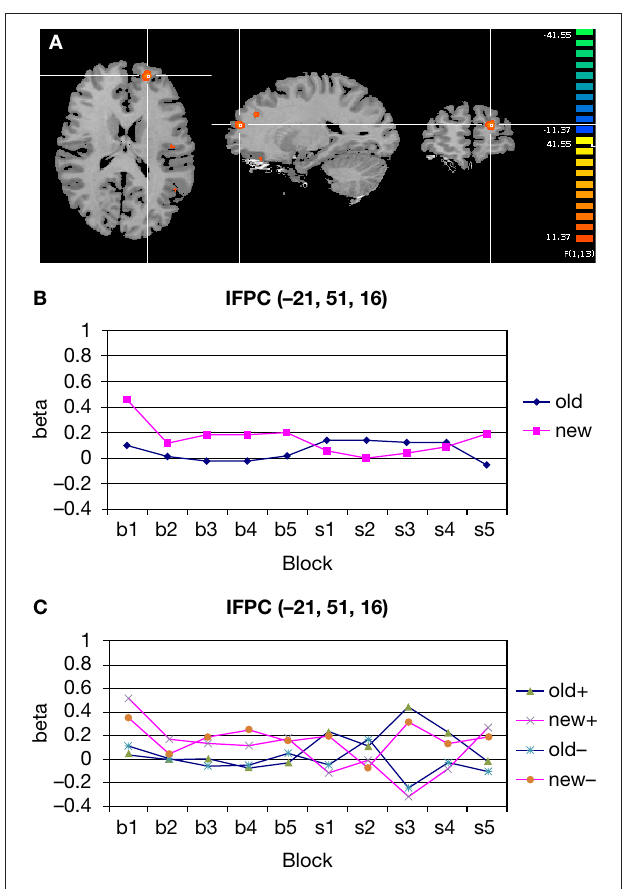
FIGURE 5 | Signifi cant confi guration by change interaction in left frontopolar cortex. (A) Location of left frontopolar activation. The frontopolar activation is marked by the cross hair. Somewhat more dorsally and posteriorly, the superior frontal gyrus activation is visible. Left hemisphere is presented on the right. (B) Group signal strength as a function of condition and block. The graph shows beta values, signifying the amplitude of the modeled BOLD-response. Old: repeated trials, new: novel trials. (C) Signal strength as a function of condition and block, separately for the high ( + ) and low ( − ) facilitation subgroups.